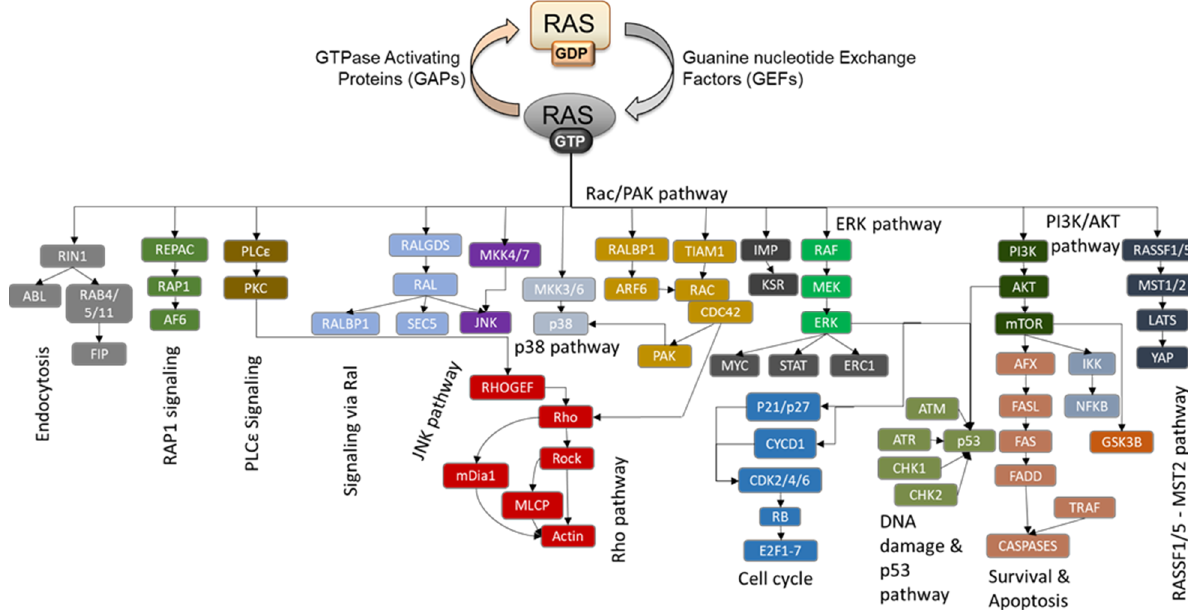
Figure 1. Known RAS effectors and signaling pathways. The RAS activation cycle comprises GTP binding aided by Guanine nucleotide Exchange Factors (GEFs), which puts RAS proteins into an active conformation where it can bind to effectors and activate downstream signaling pathways. The main and currently best-characterized RAS signaling pathways are shown. Effectors are released when GTP is hydrolyzed to GDP, and this intrinsic, but low, catalytic RAS activity is vastly accelerated by GTPase Activating Proteins (GAPs).